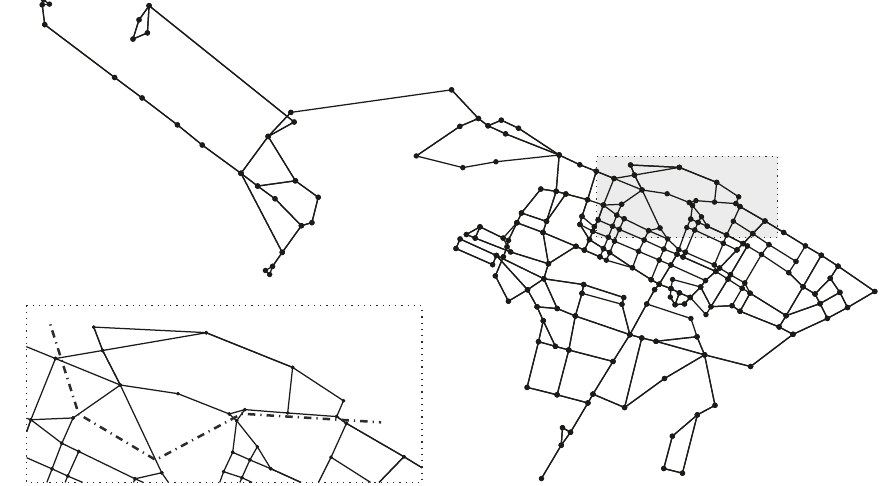
Figure 9: Network of the city of Molfetta, with a zoom on cordon road pricing scheme.